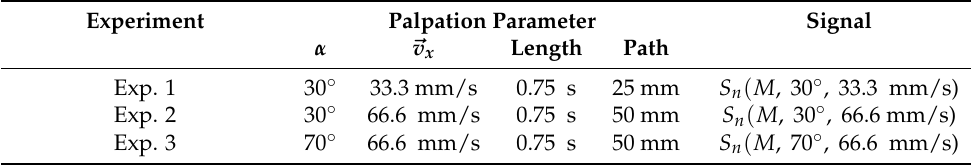
Table 1. Summary of parameters for experiments 1–3. For the acquisition of signals S n = 1 − 100 the velocities (cid:126) v y = (cid:126) v z = 0 were kept constant during the palpation phase for all three experiments. The z coordinate of the robotic arm and the height of the materials on the table were kept constant. Experiment Palpation